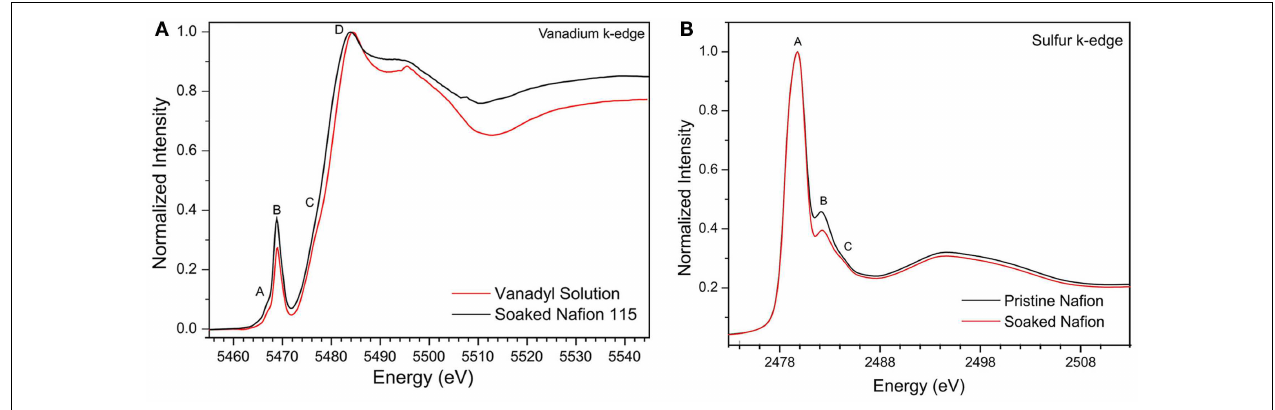
FIGURE 2 | (A) Experimental sulfur K-edge spectra of pristine and soaked Nafion 115 membrane and (B) Experimental vanadium K-edge spectra of 2M vanadyl ion solution and soaked Nafion 115 membrane. (Nafion membranes are soaked in vanadyl ion solution for 24h and subsequently washed with DI water and